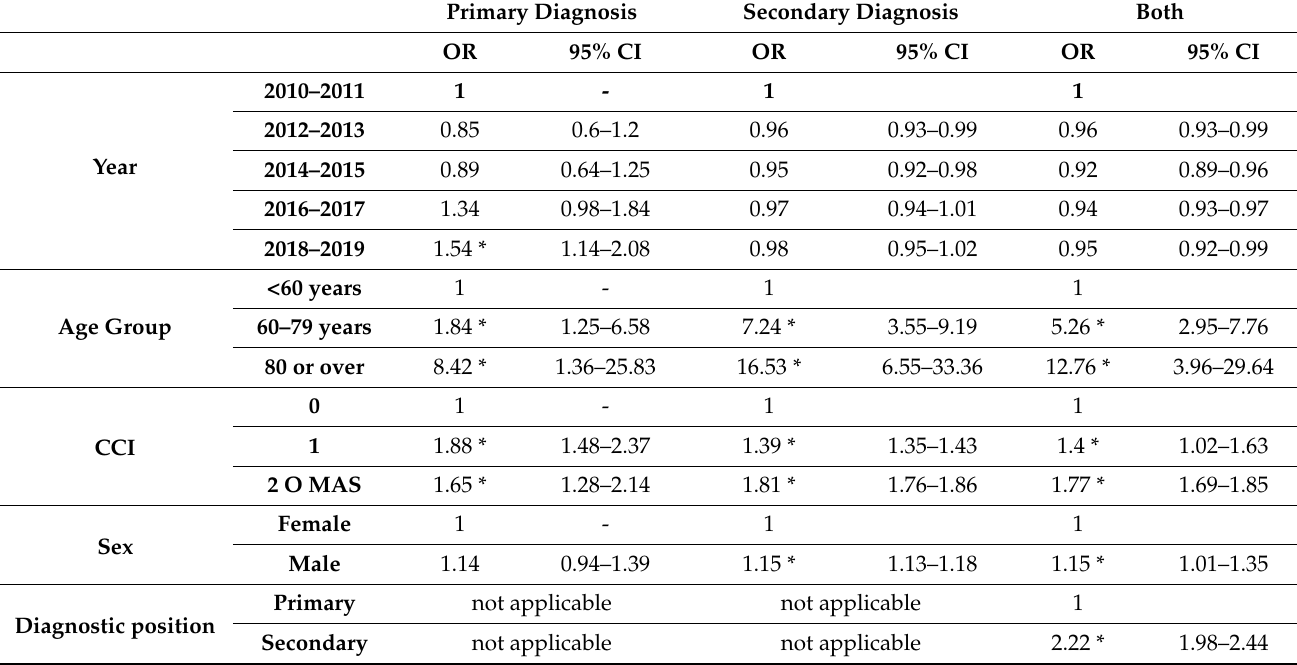
Table 6. Multivariate analysis of in-hospital mortality among patients with Parkinson’s disease codified as a primary or secondary diagnostic position. Spain, 2010–2019. Primary